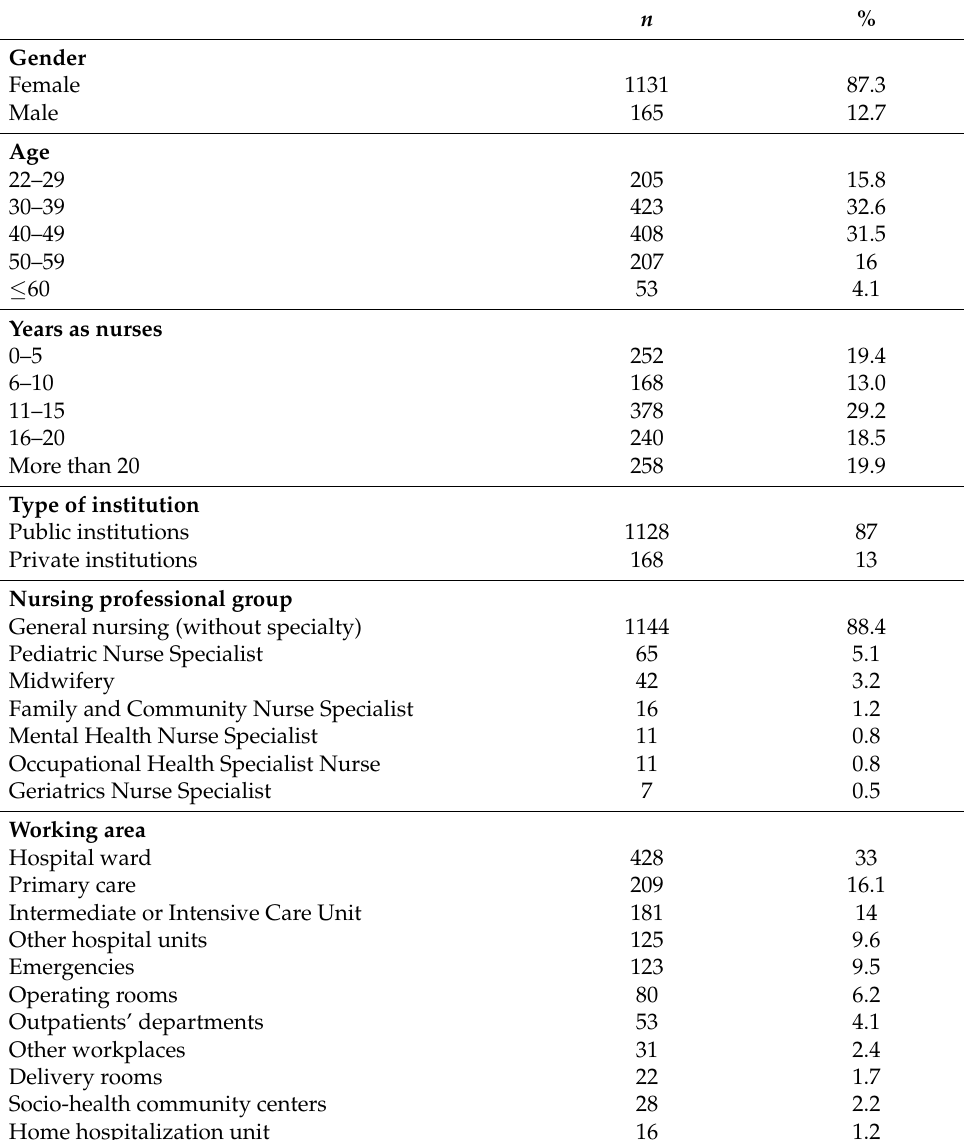
Table 1. Participants’ description ( n =